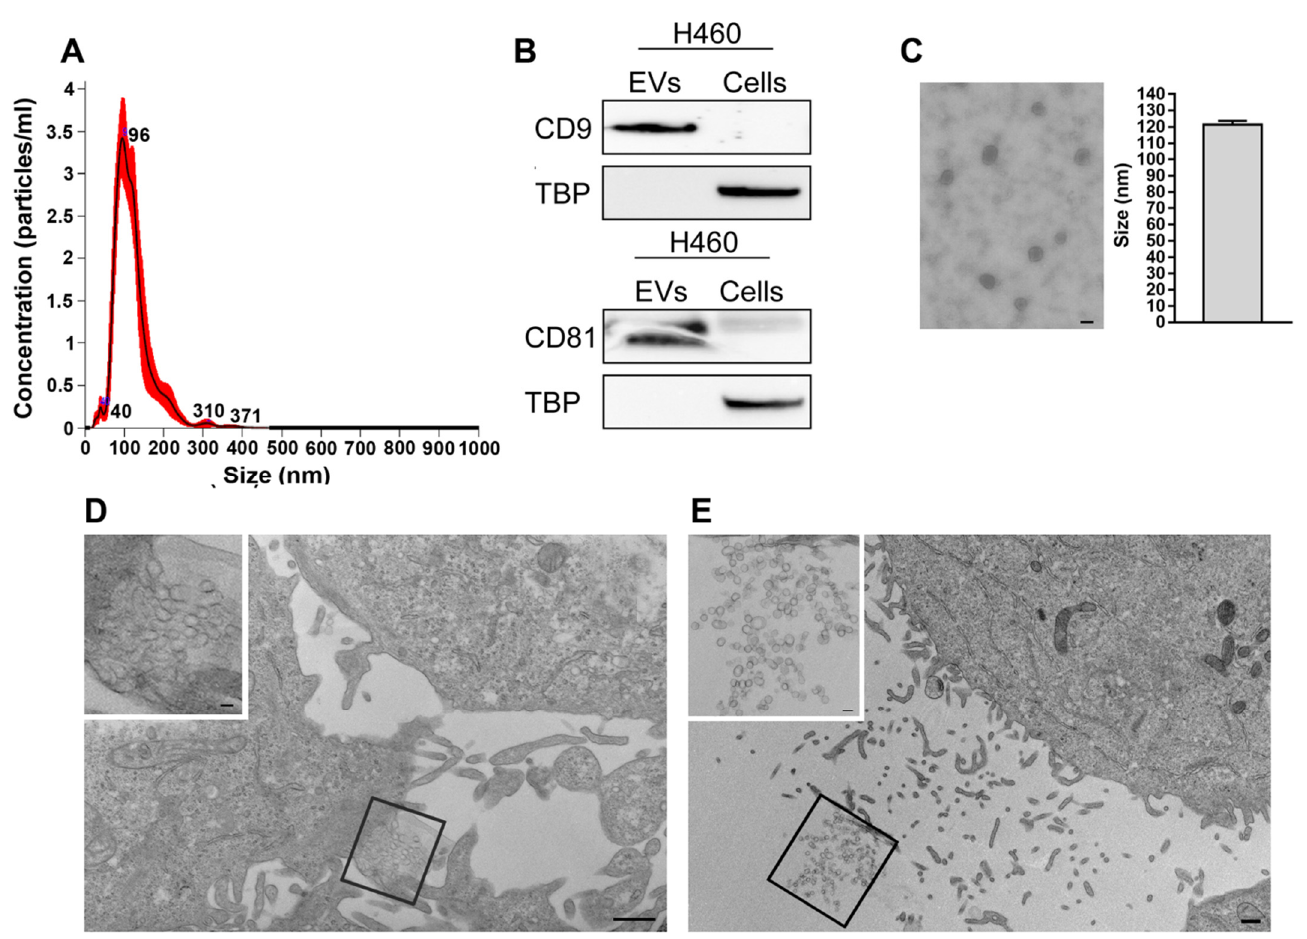
Figure 7. Characterization of EVs isolated from H460 cell line. ( A ) Size distribution of H460-derived EVs determined by NTA (NanoSight NS300 instrument-Malvern Panalytical). ( B ) Immunoblotting of the exosome-enriched proteins CD9 and CD81. H460 cellular lysates were used as a control for western blot analysis. TBP: TATA-binding protein, nuclear marker. ( C ) Representative electron microscopy image of EVs isolated from the conditioned media of H460 cells. EVs show the typical cup-shaped or round morphology of exosomes, as well as a compatible average diameter ( ≈ 120 nm). Scale bar = 100 nm. ( D ) Representative TEM image showing a new cluster of EVs enclosed by a membrane expelled by an H460 cell. Scale bar = 500 nm. In the upper left an enlargement of the boxed area. Scale bar = 100 nm. ( E ) Representative TEM image exhibiting scattered EVs in the extracellular milieu between H460 cells. Scale bar = 500 nm. In the upper left a greater enlargement of the outlined area. Scale bar = 100 nm.